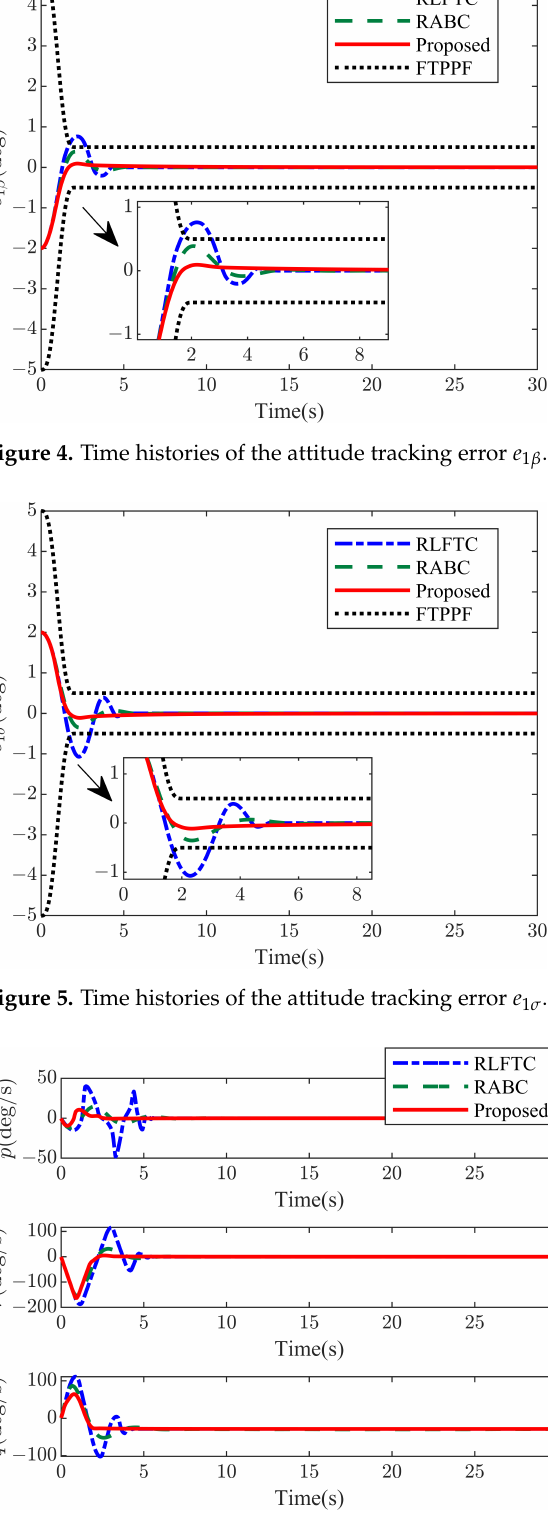
Figure 6. Time histories of the angular